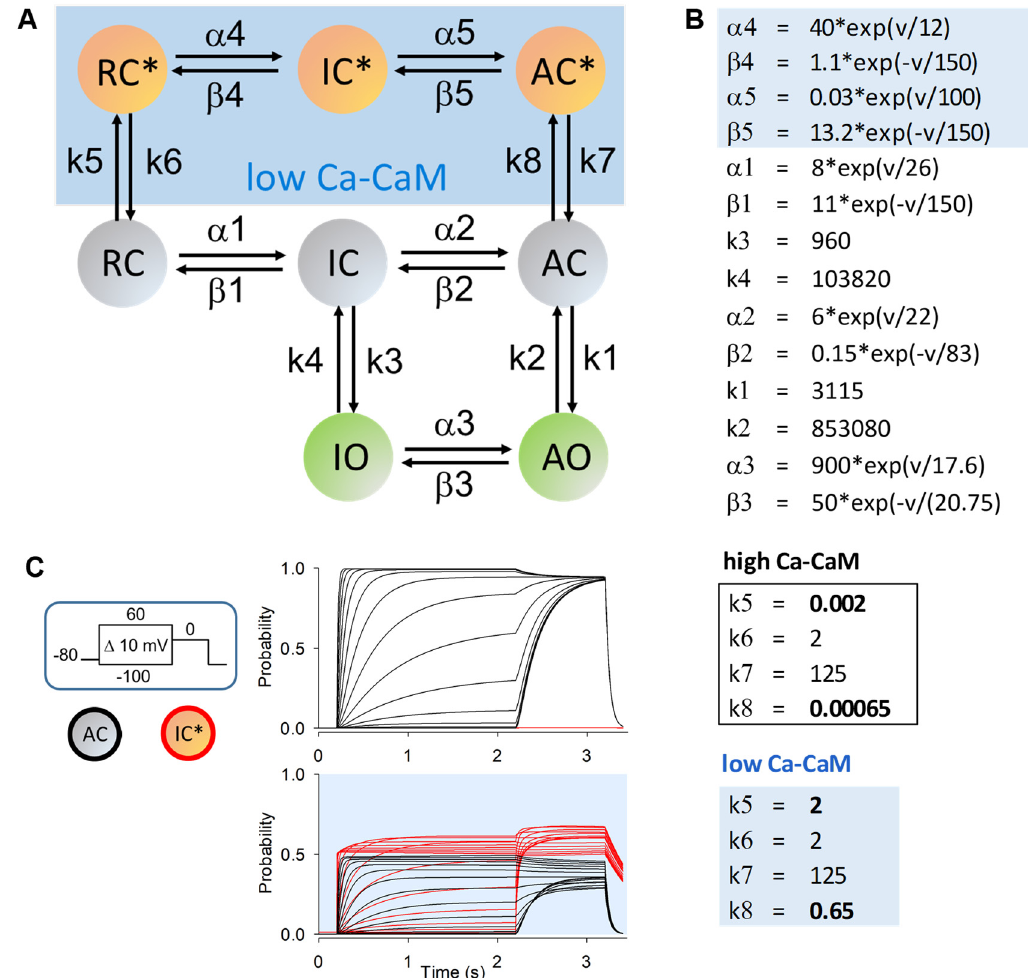
Figure A1. A Markov model considering the Ca 2+ sensitivity of the KCNQ1 WT channel. ( A ) The five-state kinetic model in the lower part (white background) of the scheme applies to homomeric KCNQ1 channels with saturating concentrations of Ca 2+ and CaM (high Ca-CaM). To account for the effects of reduced Ca 2+ , three closed states (*) were added without direct access to the open states IO and AO (low Ca-CaM; blue background). From IC*, channels have to pass through AC* to enable channel opening. ( B ) Model parameter used to describe WT KCNQ1 channel behavior with low and high intracellular Ca-CaM. k5 and k8 determine the access to *states; the ratio of k5/(k5+k6) mirrors the amount of current reduction induced by decreased levels of calcified CaM. ( C ) With low Ca-CaM, the potential- and time-dependent accumulation of channels in the AC state (black traces) is significantly reduced due to the high occupancy of the IC* state (red traces). “R”, “I” and “A” indicate the resting, intermediate or activated positions of the voltage sensor; “C” and “O” indicate the closed or open states of the channel. Simulated KCNQ1 current traces resulting from this model are shown in Figure S1 (deactivation protocol) and Figure S6 (Ca 2+ dependence: activation